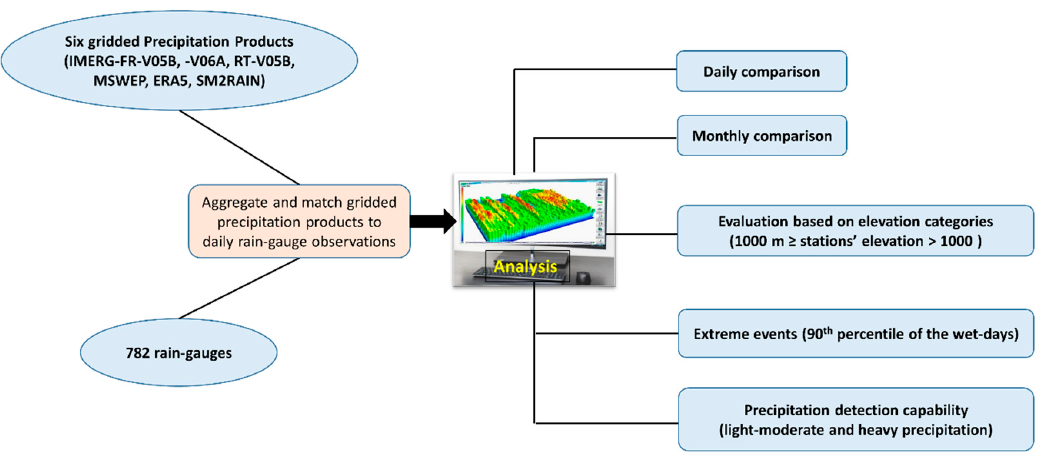
Figure 2. Processing stages for error analysis of this study.